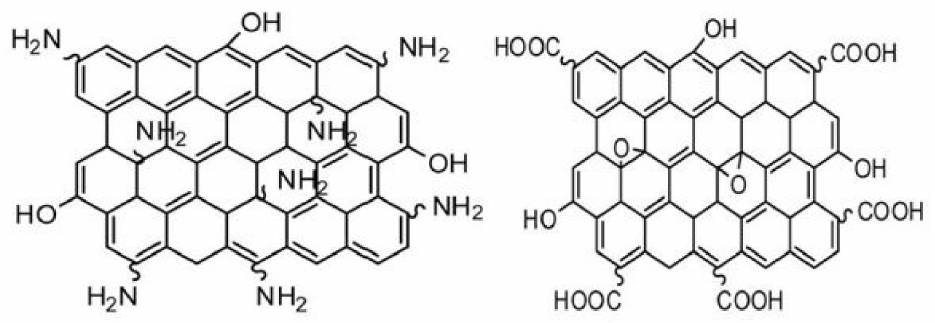
Figure 2. GO sheet functionalized with amine, carboxyl, and hydroxyl groups [41]. Reproduced with permission from International Journal of Biological Macromolecules; published by Elsevier, 2018.